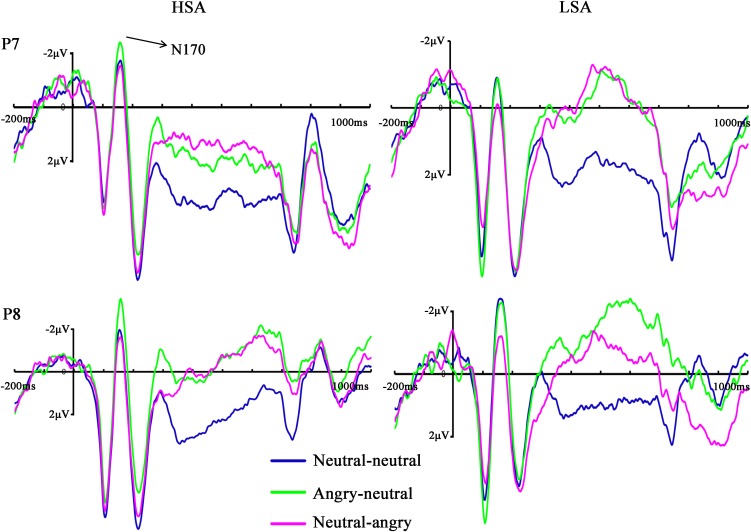
Grand mean ERPs in each facial emotional change condition at the left (P7) and right (P8) hemisphere electrodes with time window of N170 for HSA and LSA participants.